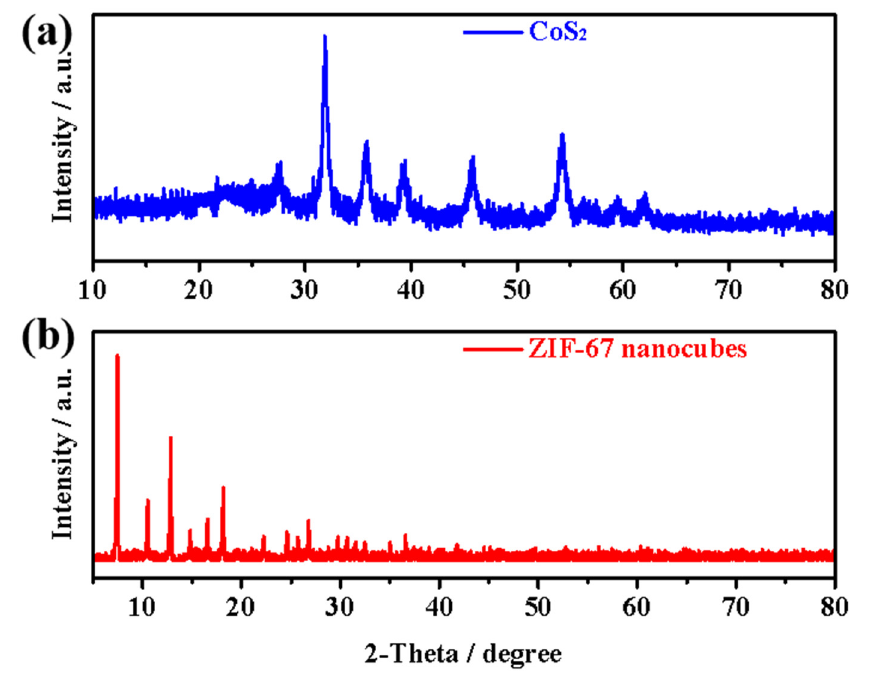
Figure 2. XRD patterns of the samples ( a ) CoS 2 hollow nanoboxes and ( b ) solid ZIF-67